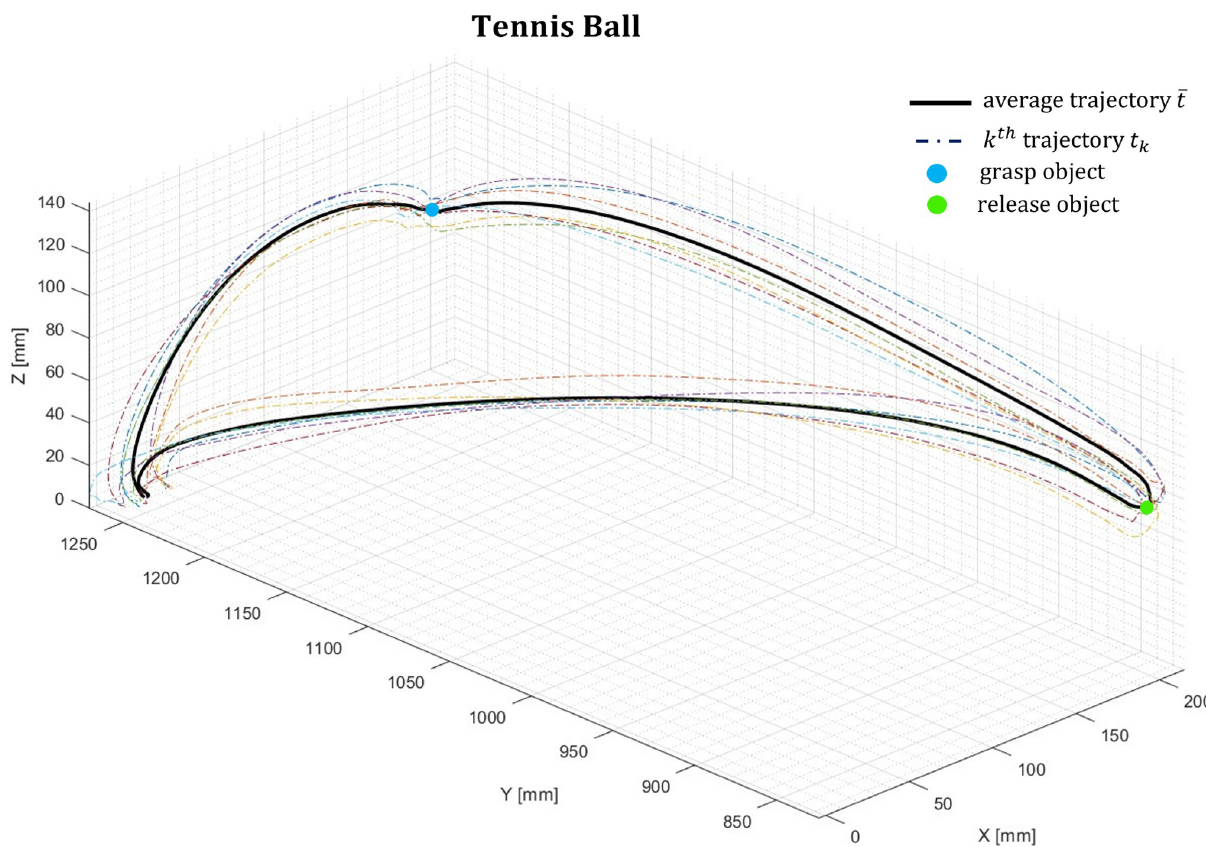
Fig 2. Trial trajectories (dash-dotted lines) and average trajectory (thick black line) for a given subject during the tennis ball manipulation task.